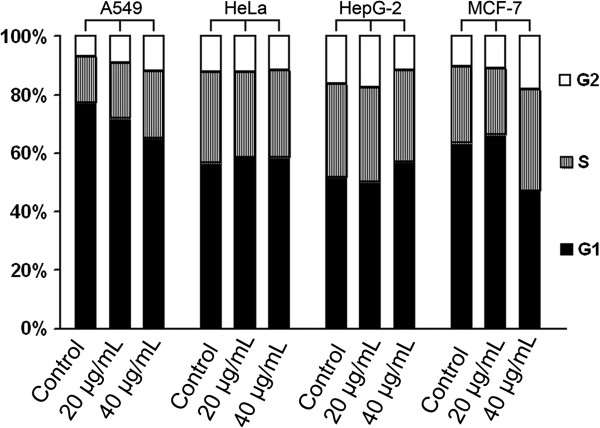
Grailsine-Al-glycoside changed cell cycle progression in A549, MCF-7, HepG2, and Hela cells. Cells were treated for 12 hr before fixing and staining with anti-α-actin.